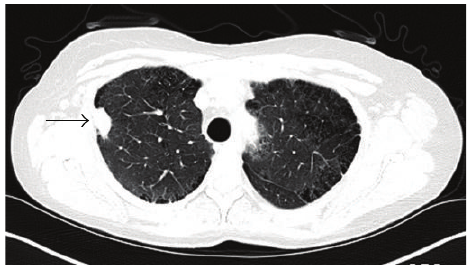
Figure 1: CT chest showing 1.5cm × 2.5 cm RUL pleural-based nod- ule (arrow).